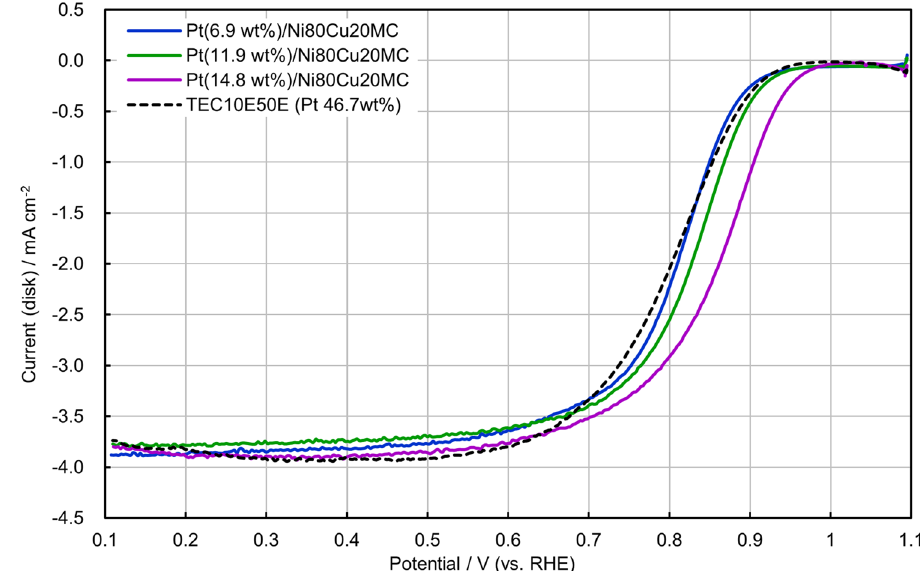
Fig. 8 Rotating ring-disk electrode voltammograms for the oxygen reduction reaction over various Pt ratios of Pt/Ni80Cu20MC in an